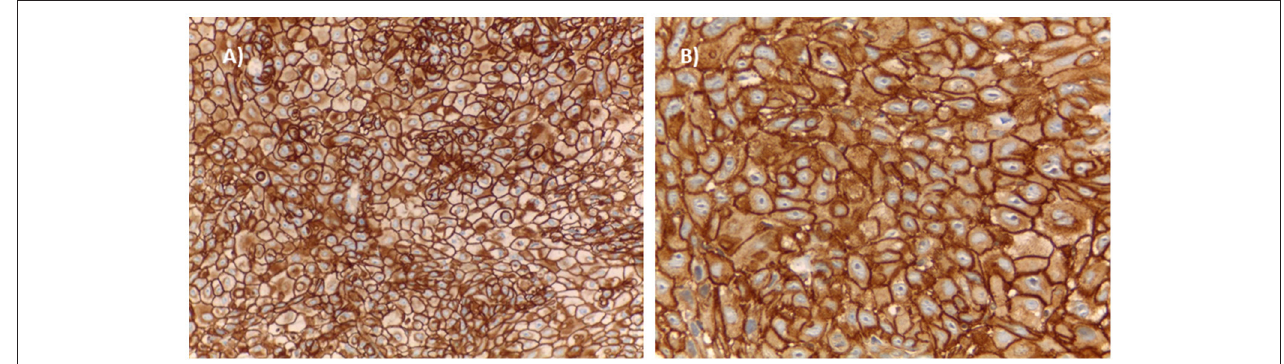
FIGURE 1 | Histopathological examples of OPC with EGFR (A) and pEGFR (B) expression.